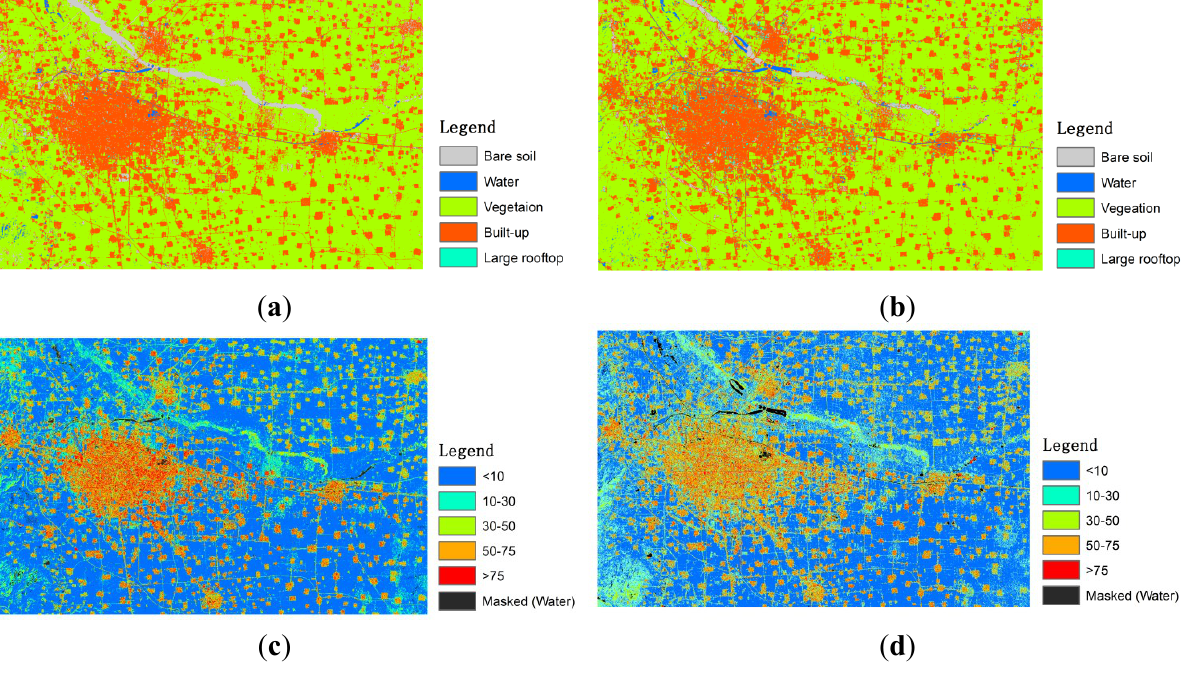
Figure 3. LCTs patterns and percent impervious surface area distribution derived from Landsat TM image in the study area on 5 September 2006 and 15 August 2010, ( a ) LCTs patterns on 5 September 2006; ( b ) LCT patterns on 15 August 2010; ( c ) percent impervious surface area on 5 September 2006; ( d ) percent impervious surface area on 15 August